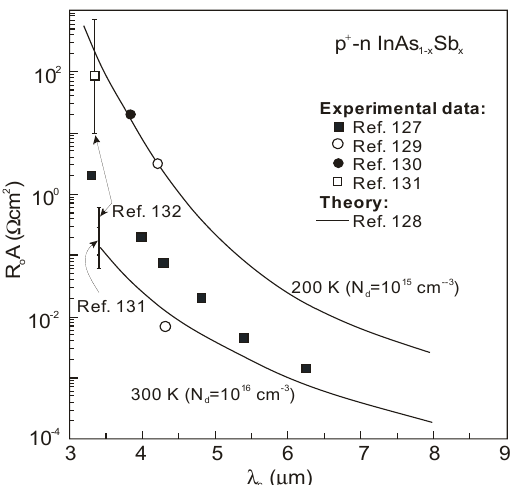
Figure 41. The R o A product versus λ cut-off for InAs 1–x Sb x DH photodiodes at temperatures 200 and 300 K. The solid curves are calculated for two doping concentrations (10 15 cm − 3 and 10 16 cm − 3 ) in the active region of photodiode with a thickness of 15 μ m; the carrier concentration of 10 18 cm − 3 in p + -cap layer with thickness equal 1 μ m is assumed. The experimental data are taken from [127] ( ∎ ), [129] (o), [130] (•), [131] ( □ ), and [132].